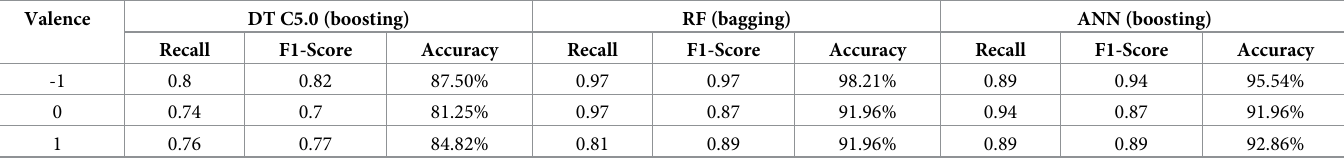
Table 9. Performance indexes of each class classification in the ternary classification model with ensemble learning.